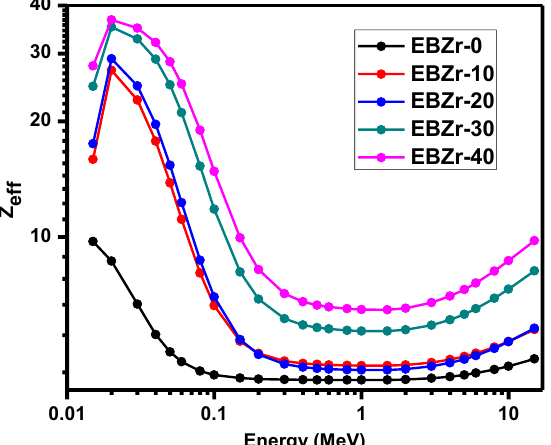
Figure 8. The variation of the effective atomic numbers of epoxy with ZrO 2 .